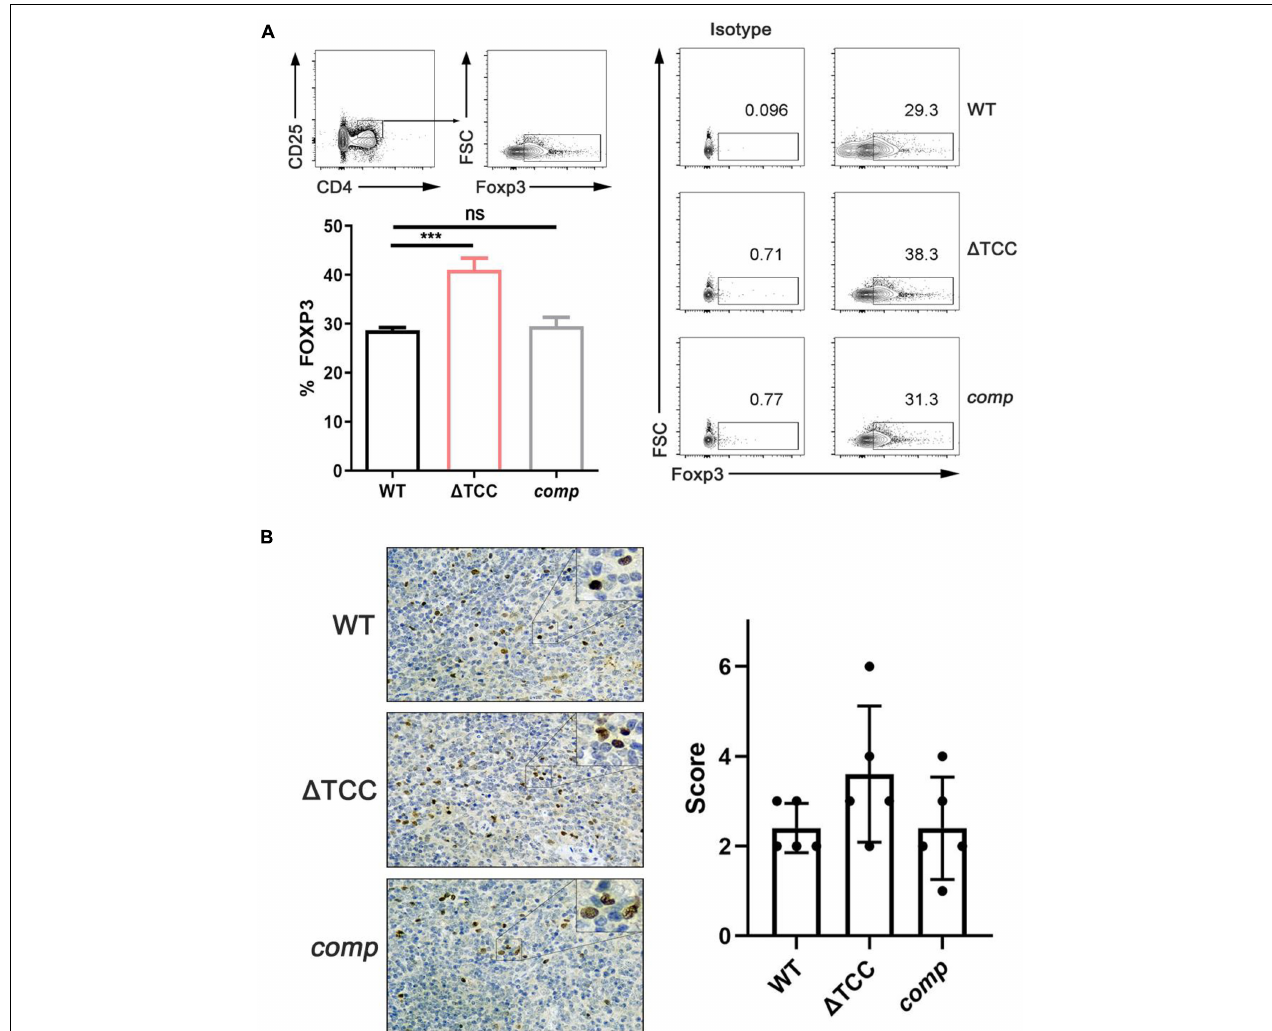
FIGURE 6 | TCC is required for inhibition of regulatory T cells. (A) Flow cytometry evaluation of CD4 + CD25 + FOXP3 + cells in spleens from mycobacteria-infected mice. FOXP3 + cells were determined by intracellular staining with anti-FOXP3 after surface staining with anti-CD4 and anti-CD25 + . Cells were stained with FOXP3 as a marker for regulatory T cells. Isotypic antibodies were used as controls. The proportion of FoxP3 + T cells within total CD4 + CD25 + T cells was significantly higher in (cid:49) TCC compared to WT ( n = 3 biological replicates per each group, data are shown as the mean ± SEM, one-way ANOVA with Dunnett’s multiple comparison test performed for (cid:49) TCC, compared with WT group; ns, not significant, *** p < 0.001). (B) Immunohistochemical evaluation of FOXP3 + cells in mice spleens. 400 × magnifications, respectively. Similar results were observed in all spleens evaluated ( n = 5). Bar = 200 µ m. Specimens were scored according to the intensity of the dye color and the number of positive